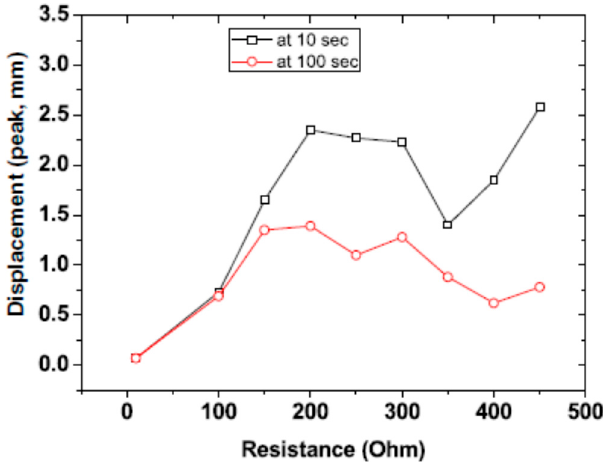
Figure 11. Effects of the charge dissipation resistance on the bending displacement of the CPIL-EAPap actuator: Bending displacements at 10 and 100 s [101].